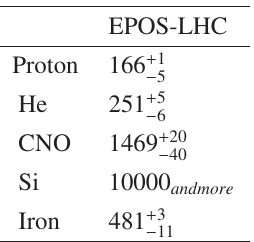
Figure 9: The number of experiments when anisotropy ap- pears as a function of the number of events.The solid line shows the median value of the energy spectrum param- eters, and plotted line shows Upper and lower limits of energy spectrum error bars.Proton, He, CNO, Si, Iron are indicated as Red, Orange, Purple, Cyan, Blue. Table 5: The number of event which required to find Xmax anisotropy.The solid line shows the median value of the energy spectrum parameters, and plotted line shows Upper and lower limits of energy spectrum error bars.Proton, He, CNO, Si, Iron are indicated as Red, Orange, Purple, Cyan,